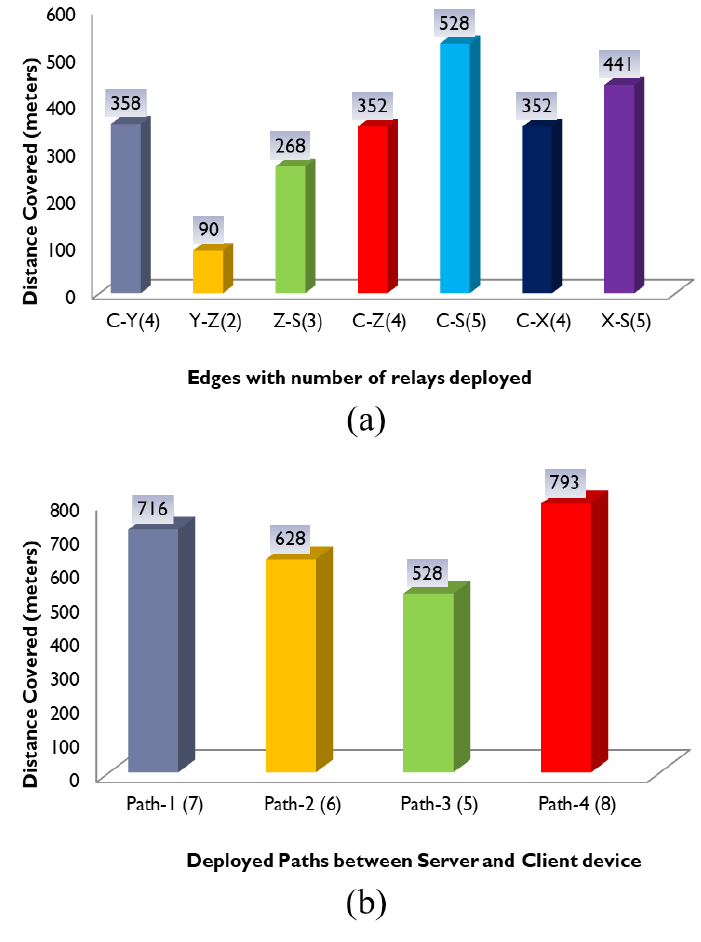
Figure 9. Distance covered by edges and